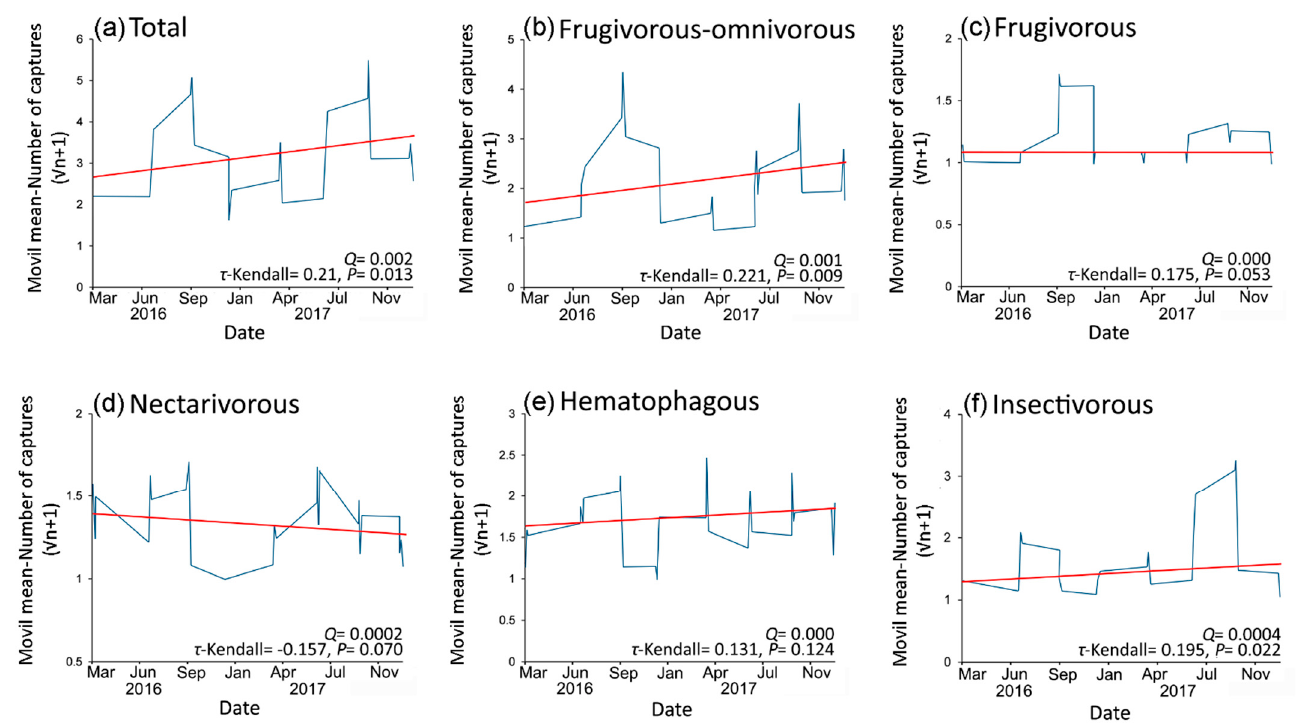
Figure 6. Post-hurricane trends in the abundance of bats, total ( a ) and by trophic guilds ( b – f ), from March 2016 to December 2017. Sen’s slope (red line) adjusted to smoothed curve (blue line).